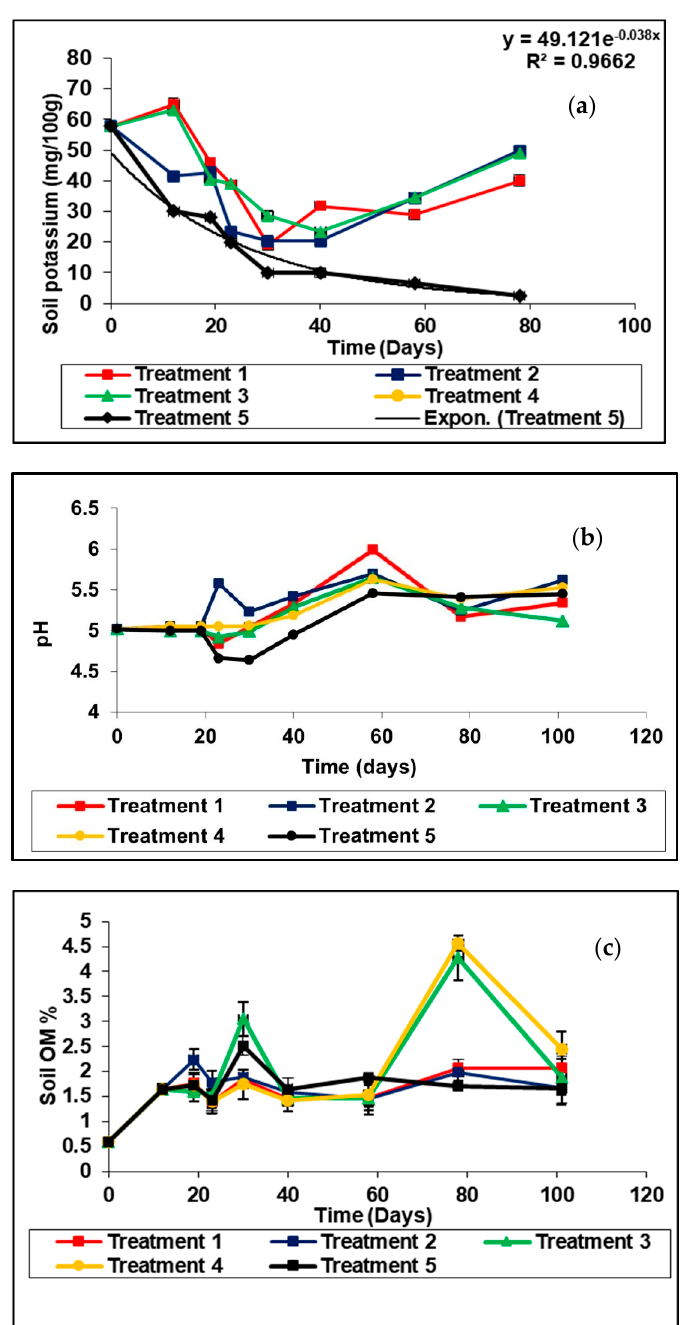
Figure 4. Variation of ( a ) potassium in soil with different treatments; ( b ) pH of the soil with different treatments; ( c ) organic matter of soil with different treatments in the pot experiment. Each data point is a mean of four replicates. Treatment 1 − inorganic fertilizer only (Urea, TSP and MOP), Treatment 2 − rice husk biochar coated Urea, TSP and MOP, Treatment 3 − inorganic fertilizer (Urea, TSP and MOP) with anaerobically digested rice straw compost only, Treatment 4 − rice husk biochar Urea, TSP and MOP with anaerobically digested rice straw compost and Treatment 5 − no fertilizer as